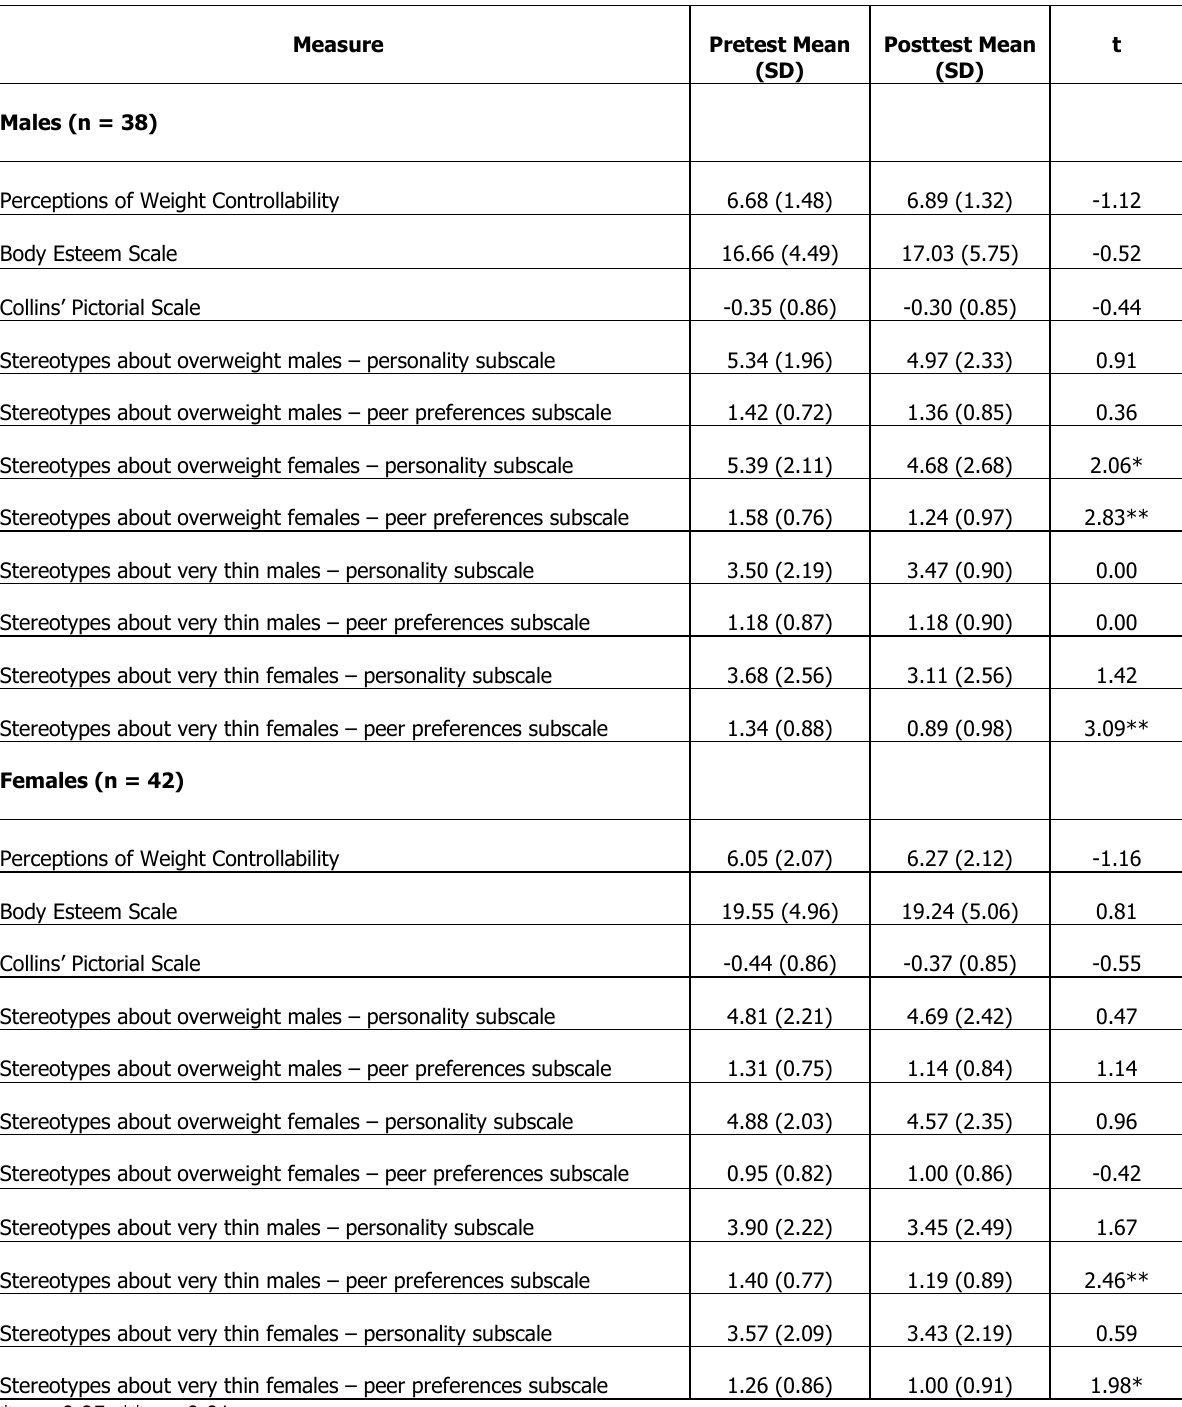
Paired Sample T-tests Comparing Pre- and Posttest Scores on Perception of Weight